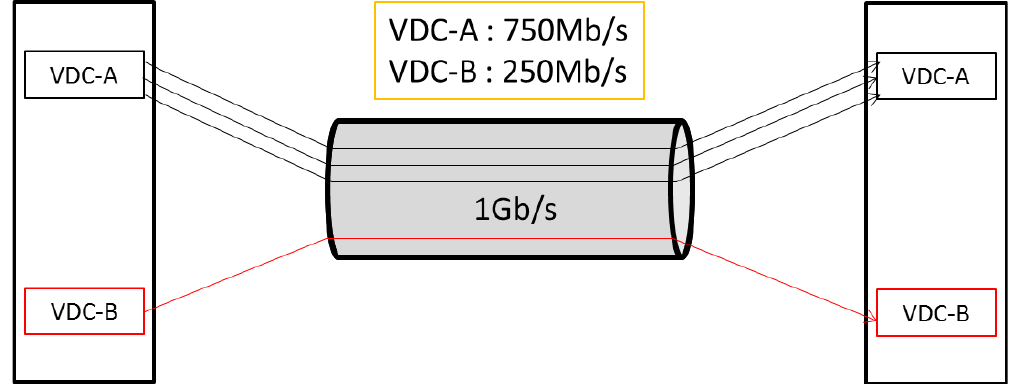
Figure 1. Unfair bandwidth allocation among